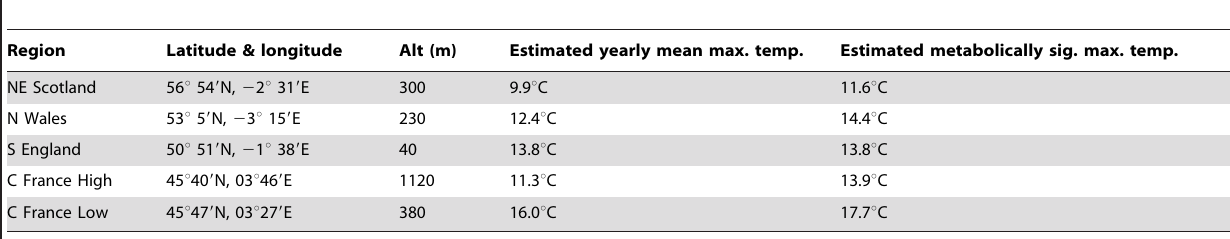
Table 1. Location and climate details of the five geographic locations from which ticks were collected (see methods for estimation of metabolically significant maximum temperature).